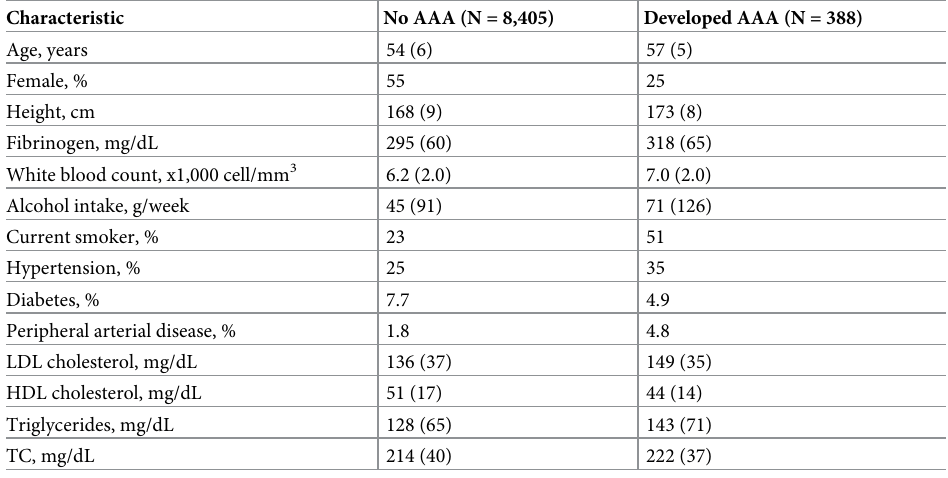
SD: standard deviation; LDL cholesterol: low-density lipoprotein cholesterol; HDL cholesterol: high-density lipoprotein cholesterol; TC: total